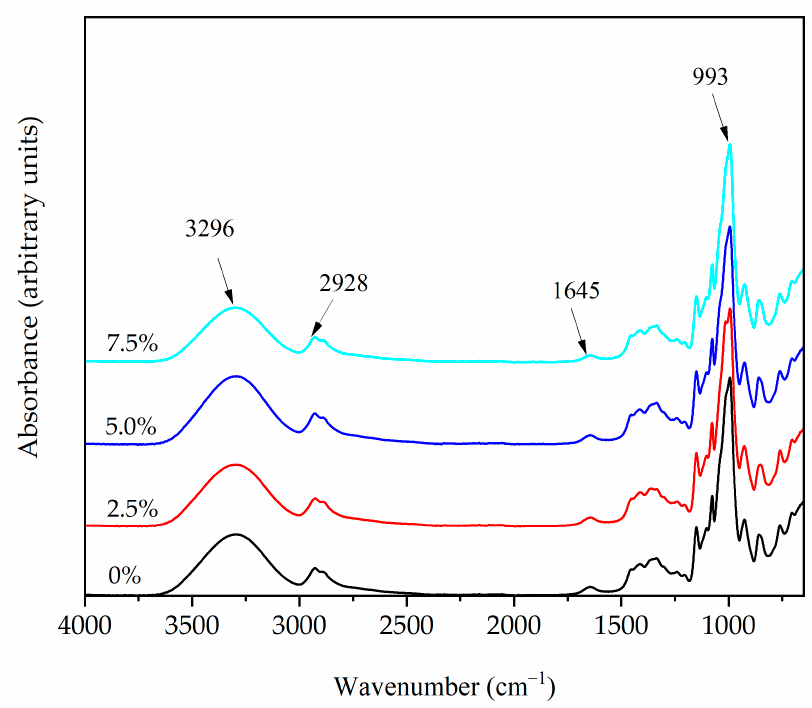
Figure 7. Fourier transform infrared spectra of cassava starch films reinforced with quinoa starch nanocrystals at different concentrations.